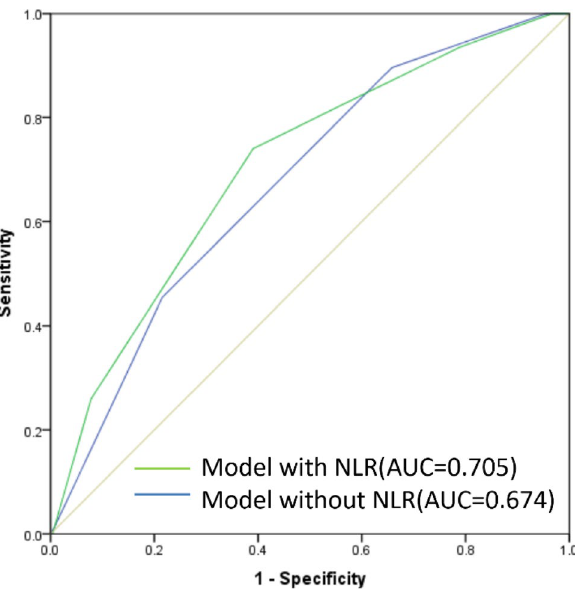
Figure 3. Receiver operating characteristic (ROC) and area under the curve (AUC) analyses pertaining to the predictive scoring